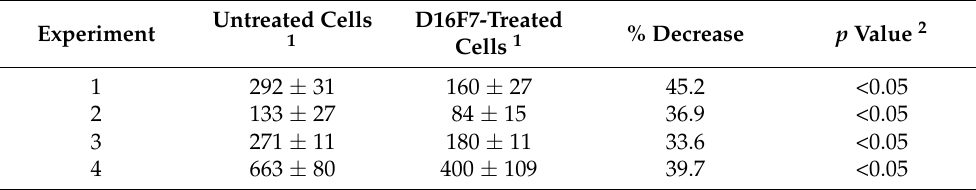
Table 1. Effect of the anti-VEGFR-1 D16F7 mAb on PlGF release in the culture medium by B16F10